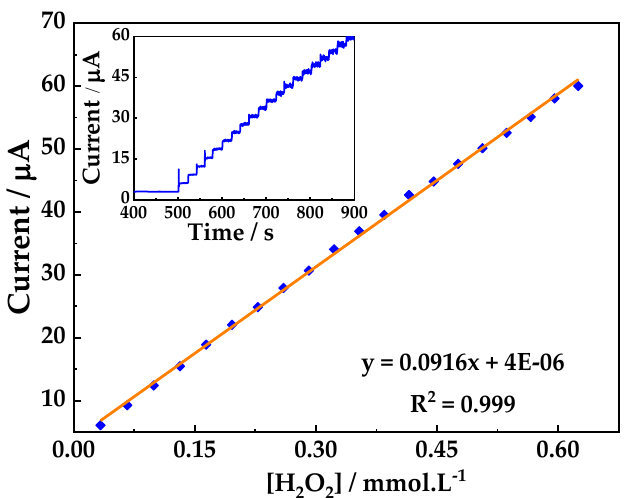
Figure 11. Chronoamperometric detection of H 2 O 2 at the PB / ZrO 2 -fCNTs / GC electrode, in a 0.1 mol · L − 1 PBS (pH 6.8) solution and its calibration curve. Working potential of 1.0 V vs. Ag / AgCl.